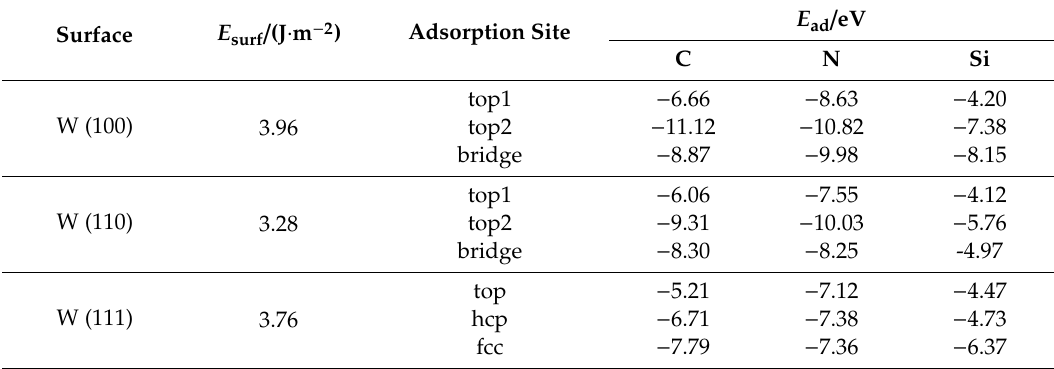
Table 2. The calculated surface energy ( E surf ) of the studied W surfaces, and the absorption energy of C, N, and Si atoms on di ff erent sites. Di ff erent adsorption sites are depicted in Figure